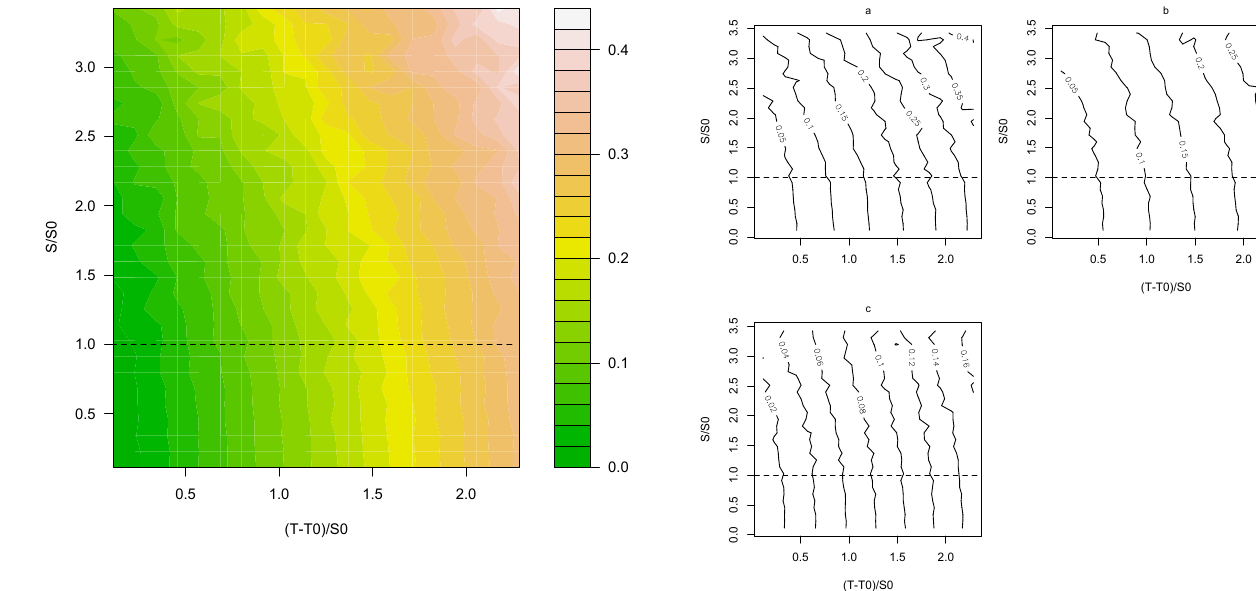
Fig. 4. Mean and Standard deviation Change (MSC) plot for H. J. Andrews using the modified van’t Hoff equation with Q 10 = 4 showing standardized changes in the mean ( T - T 0)/ S 0 against stan- dardized standard deviation S / S 0. Colors represent values of δR , i.e., the proportional increase in respiration over 10yr from one cli- matic regime over the other. The dashed horizontal line represents simulations in which variance remained constant relative to the ref- erence climatic regime. S / S 0 > 1 represents increase in variance and ( T - T 0)/ S 0 > 0 represents increase in average temperature.